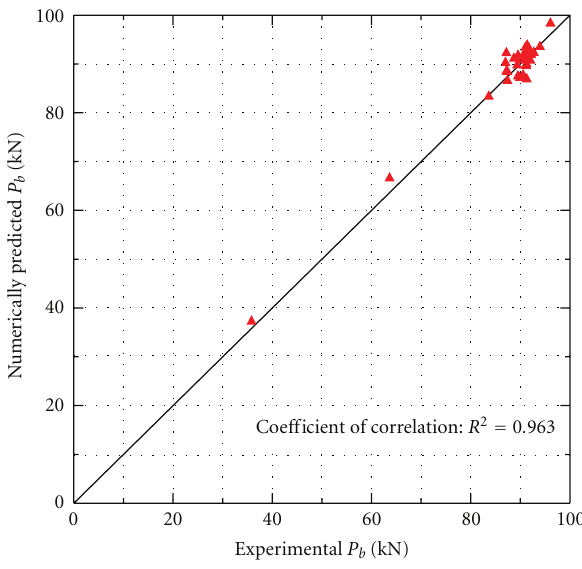
Figure 8: Comparison of experimental and analytical ultimate load